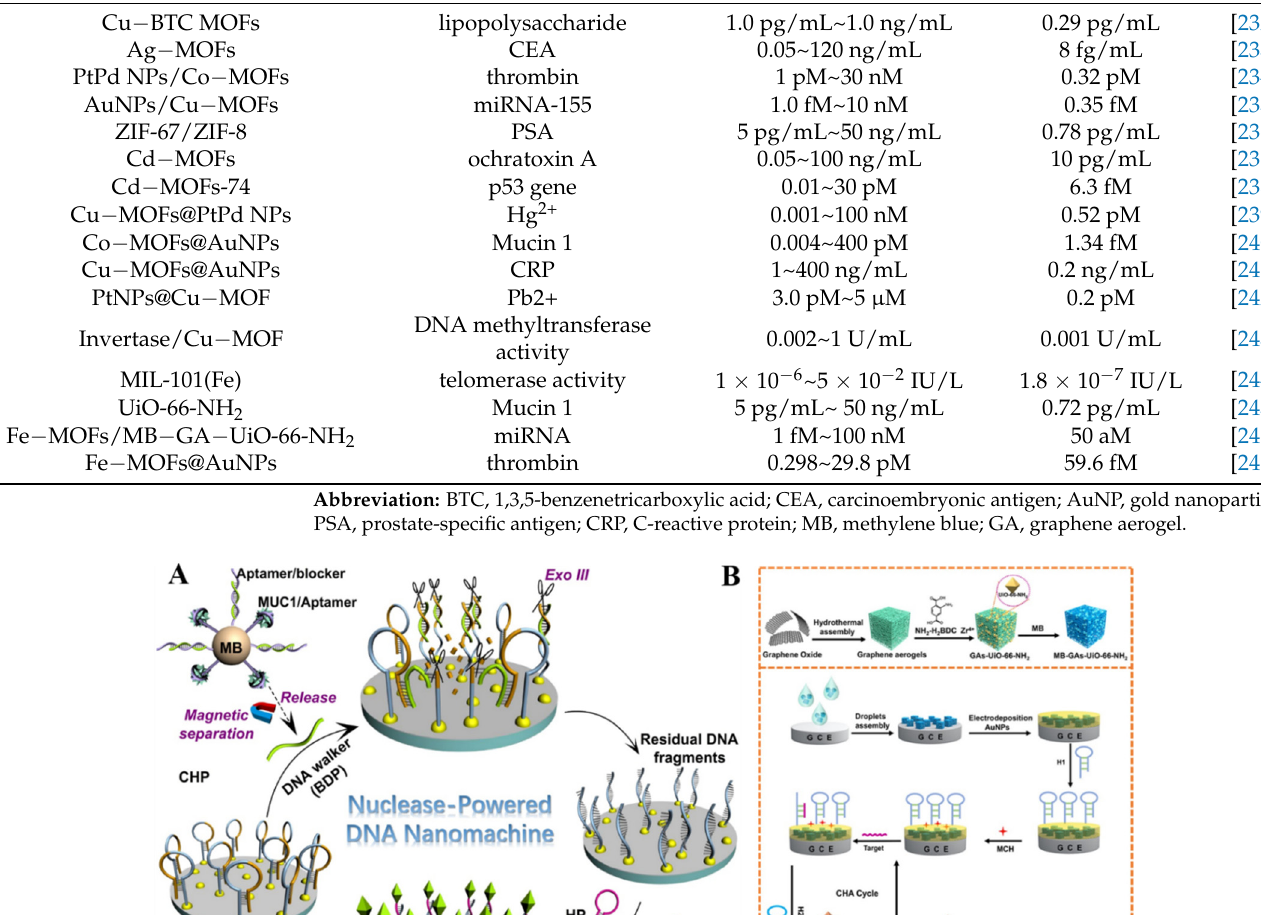
Table 7. Detection performances of different electrochemical sensors by using MOFs as electroactive labels.